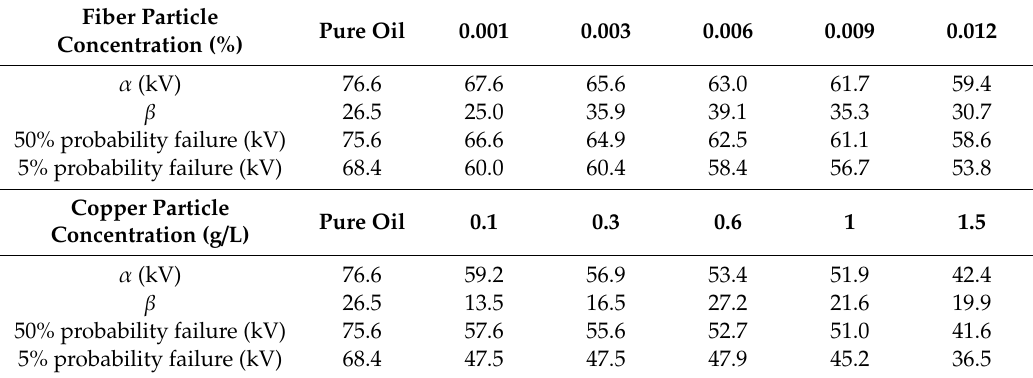
Table 3. Weibull parameter of characteristic DC breakdown for contaminated mineral oil.